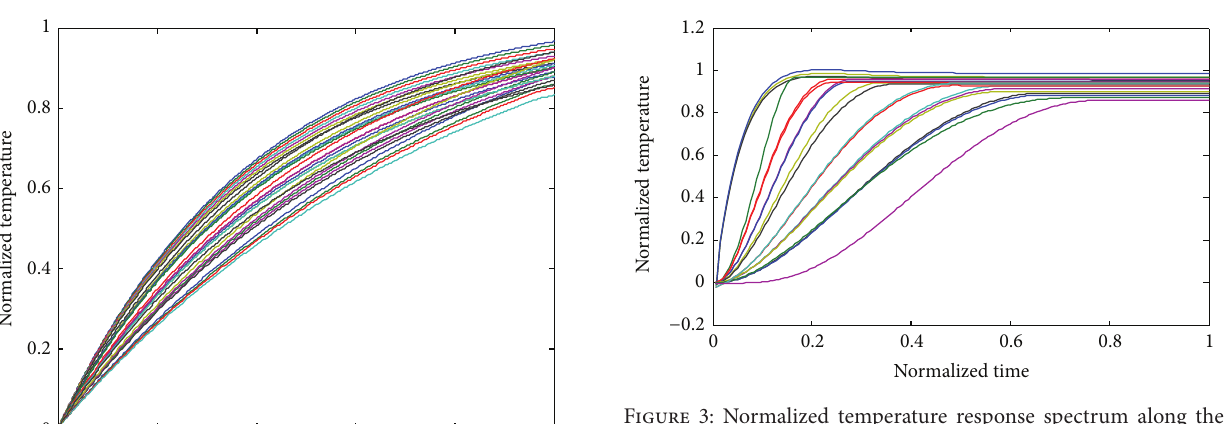
Figure 3: Normalized temperature response spectrum along the center of the slab in the case of 𝑍 𝑇 = 0.05 .